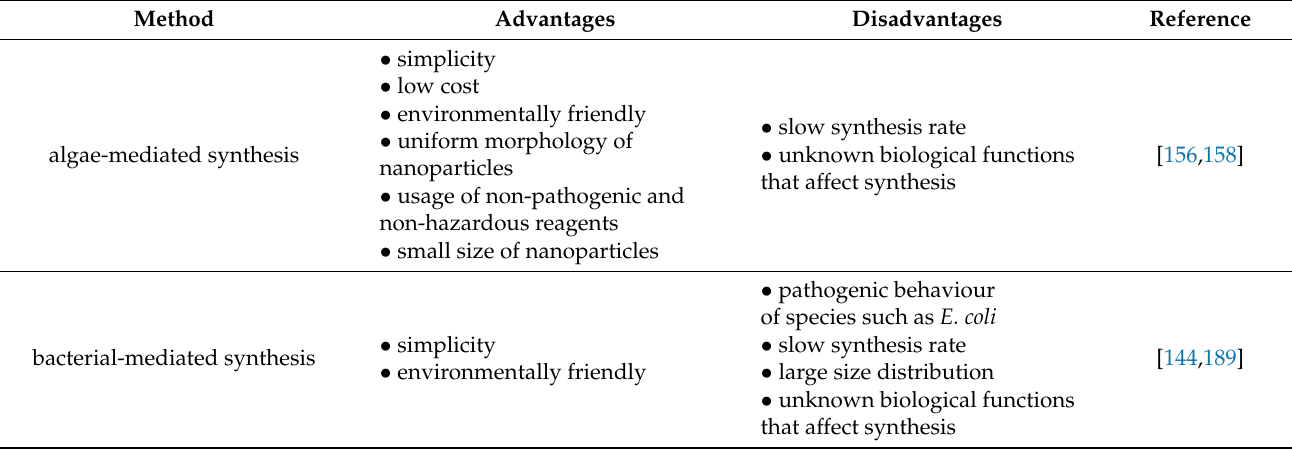
Table 1. Green synthesis methods of silver nanostructures: comparison and classification [144,156,